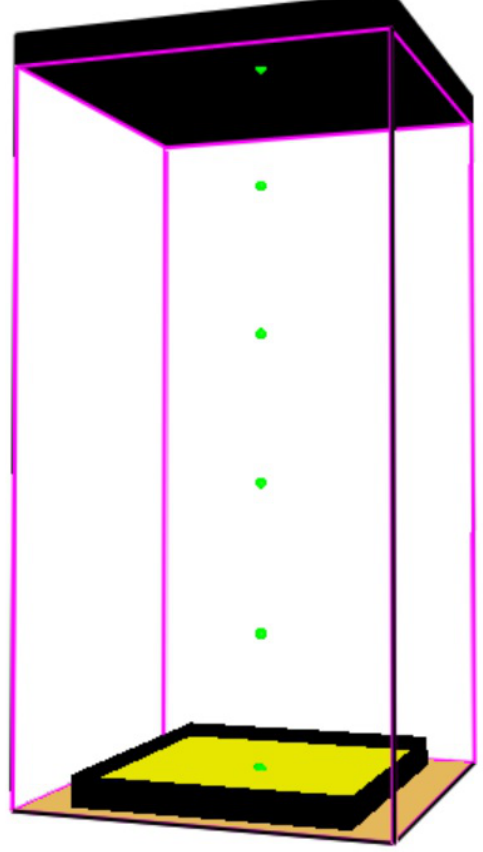
Figure 13. The geometry of the Heptane burner.